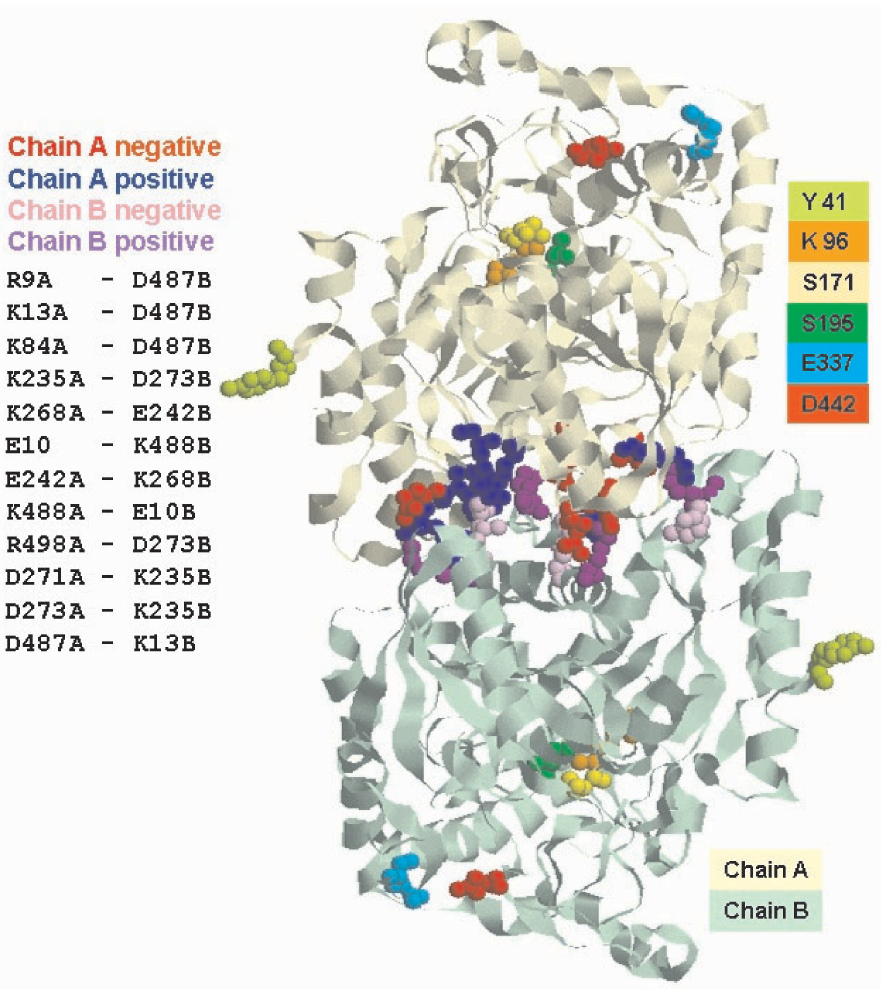
Figure 7. Model of the Sulfolobus solfataricus amidase (SSAM) dimer. Puta- tive model of the SSAM dimer: charged ion-pair resi- dues putatively involved in the electrostatic interactions (posi- tively charged groups are blue and magenta, negatively charged groups are red and pink) between the two mono- mers are highlighted. Also shown are the catalytic triad (K96 (orange), S171 (yellow) and S195 (green)) at the active site, E337 (light blue) and D442 (red) at the entrance of the active site and Y41 in bril- liant green.